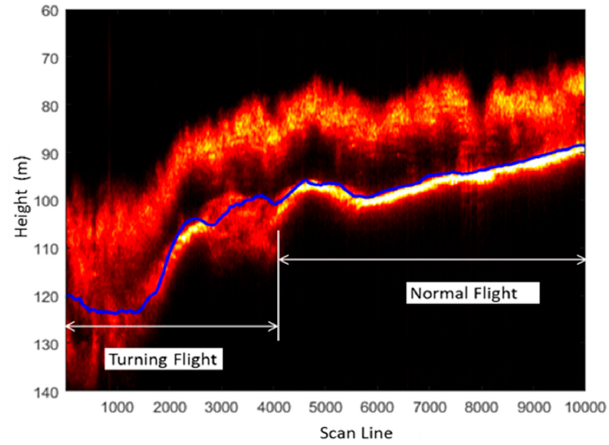
Figure 9. Ground level and stand profile from co-polarization (HH) while the helicopter is banking and during level flight.